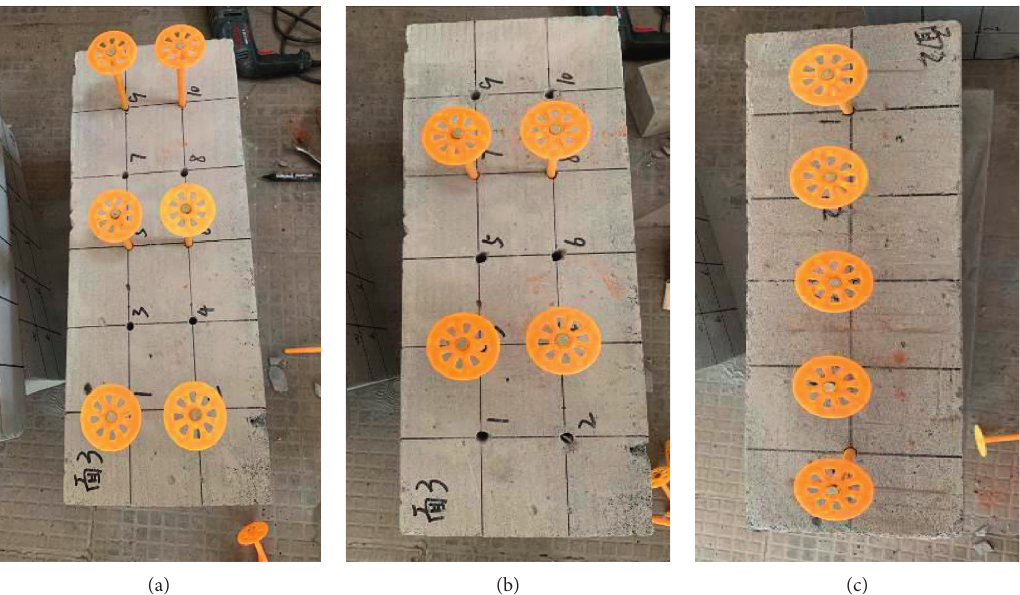
Figure 4: Anchor bolt layout. (a) The first batch in the main view. (b) The second batch in the main view. (c) Side view.